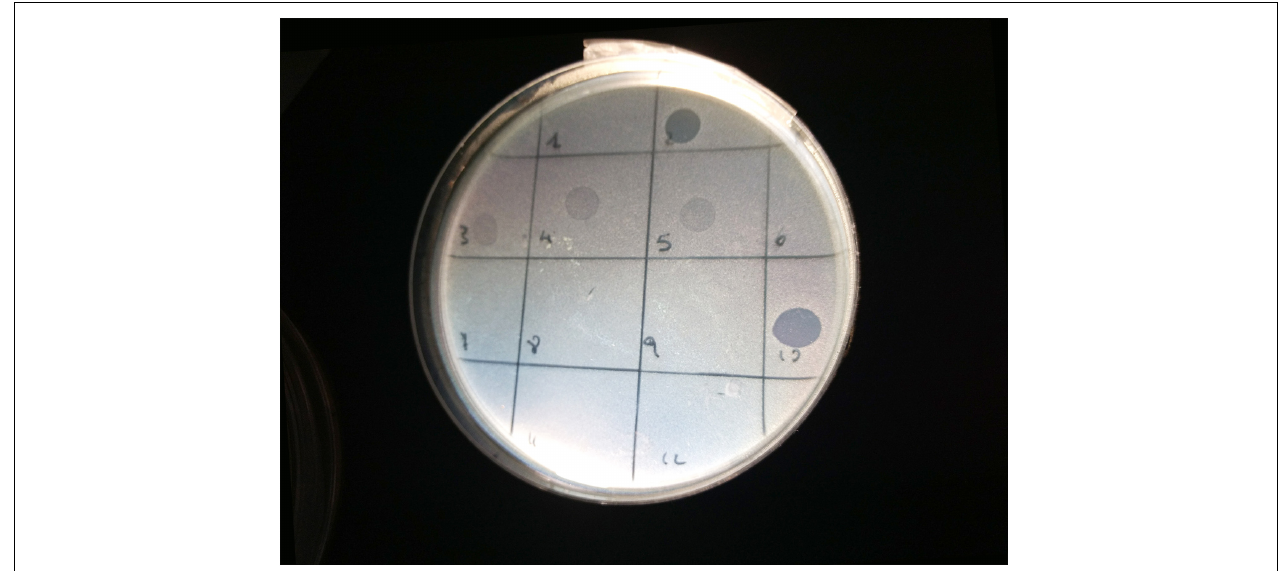
FIGURE 1 | Image of spot test for the bacterial strain 33C (serogroup O23): phages LF2 (square 2) and FM10 (square 10) produced clear lysis plaques; phages FM3 (square 3), LF4 (square 4), and FM5 (square 5) generated turbid plaques; phages FM1 (square 1), FM6 (square 6), LF7 (square 7), FM8 (square 8), FM9 (square 9), FM11 (square 11), and LF12 (square 12) did not show any